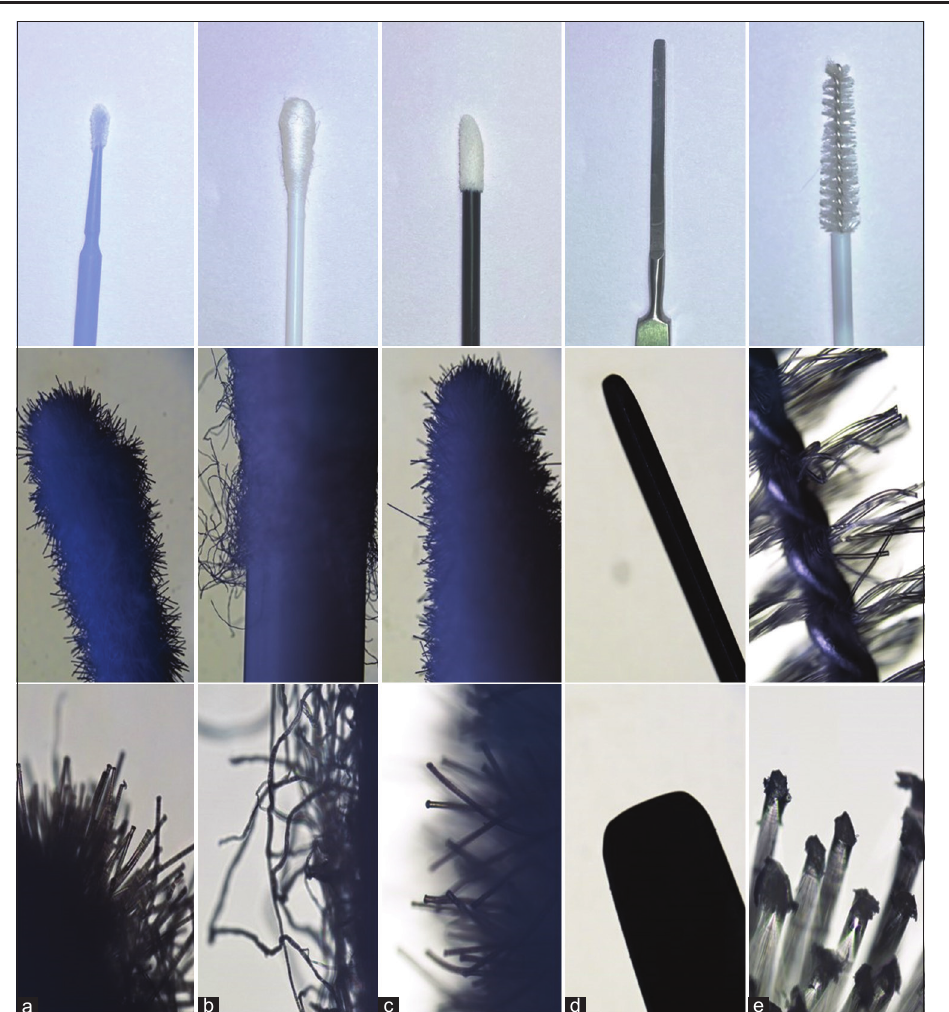
Figure-1: Cytological sampling instruments in native size. Line 1 (a) mini brush, (b) cotton swab, (c) soft brush, (d) spatula, (e) cytobrush. Line 2 (magnified 20×). Line 3 (magnified